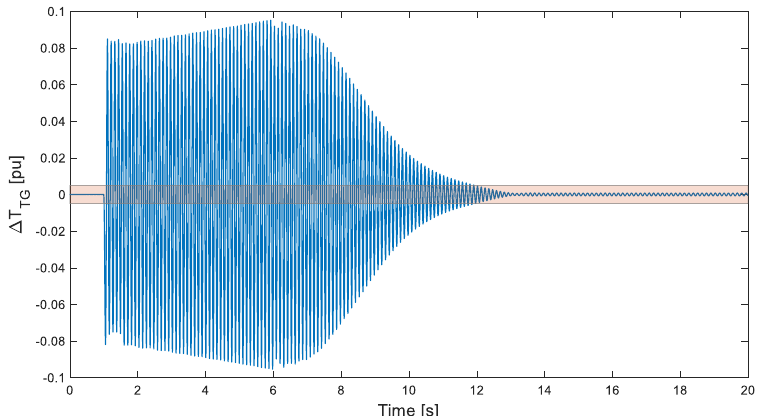
Figure 5. Torque oscillation ∆ T TG at the first TNF with and without the action of the SSD converter with the proposed control system.